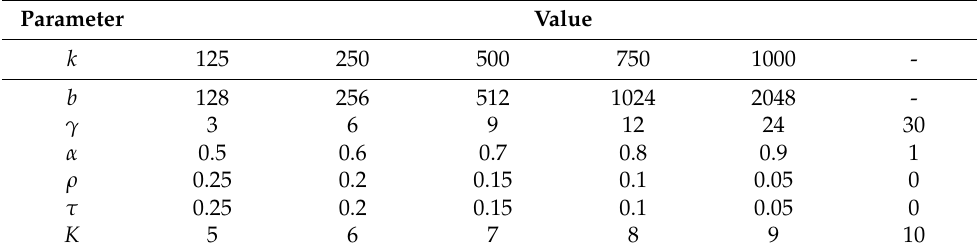
Table 2. The parameter